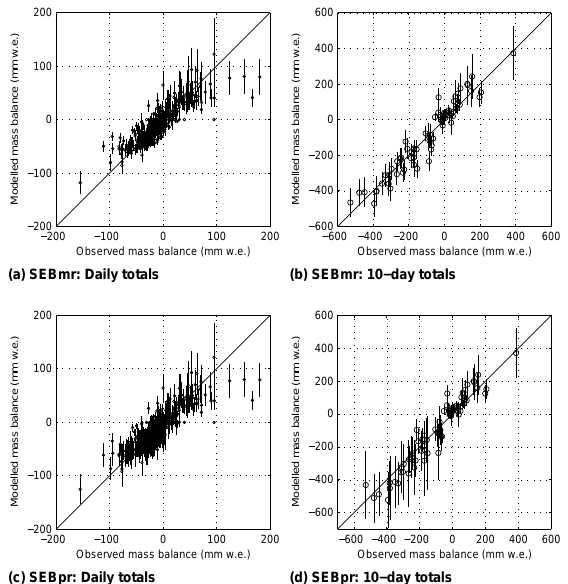
Figure 5. Observed versus modelled mass balance for (a, b) SEBmr and (c, d) SEBpr over 1-day and 10-day periods. Error bars show ± 2 σ from the ensemble mean values. The solid diagonal line is a 1 : 1